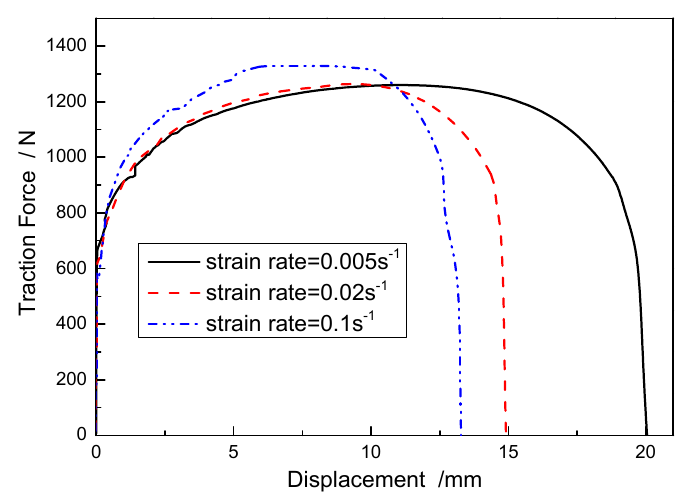
Figure 2. Traction force versus displacement in tensile test.